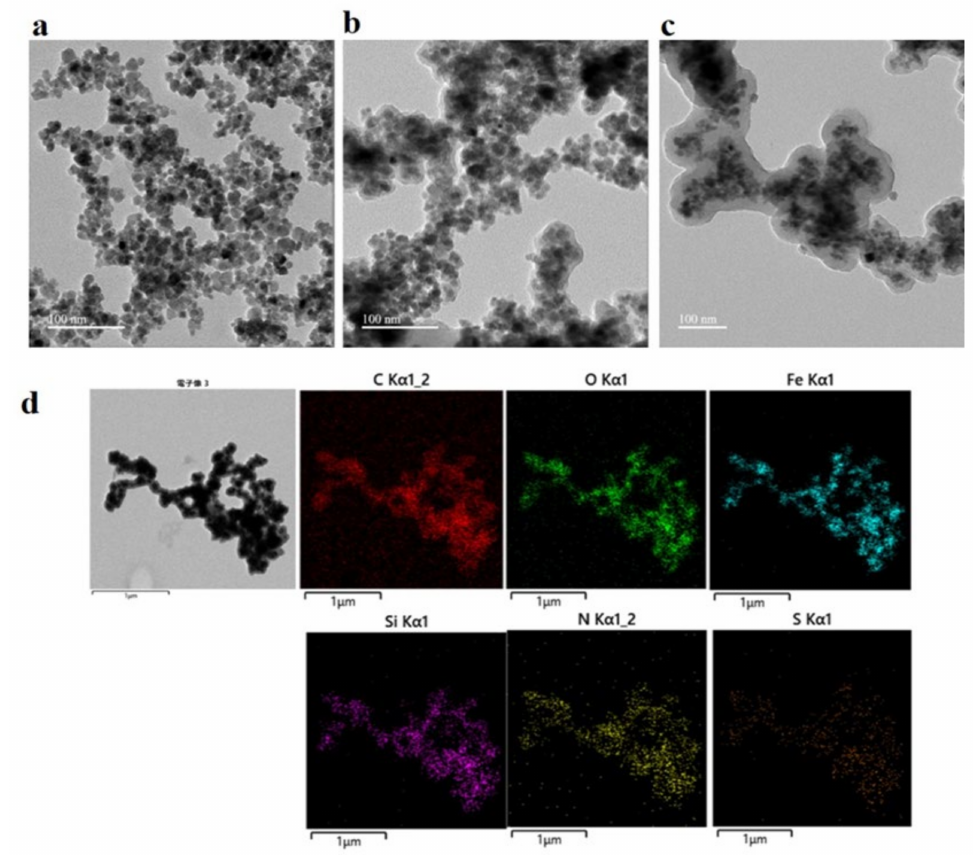
Figure 1. TEM images of ( a ) Fe 3 O 4 -NH 2 , ( b ) magnetic 3D COFs, ( c ) magnetic 3D COF–GSH MIPs, and ( d ) EDS elemental mapping of magnetic 3D COF–GSH